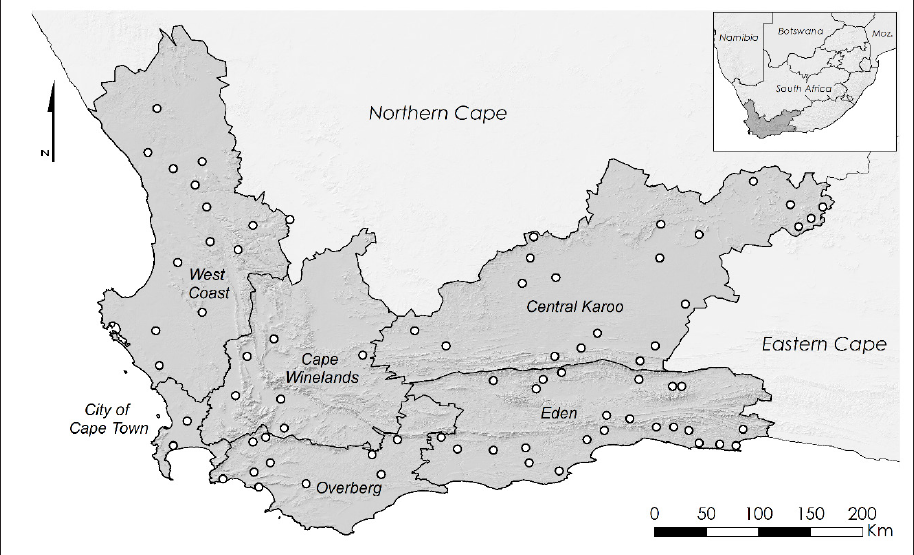
The Western Cape Province of South Africa showing the location of the 76 rainfall stations included in the